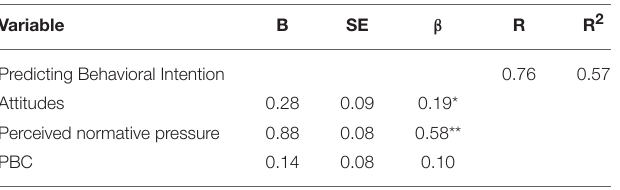
TABLE 2 | Means, standard deviations, and correlation coefficients for the reasoned action model components ( N = 138). Variable B SE β R R